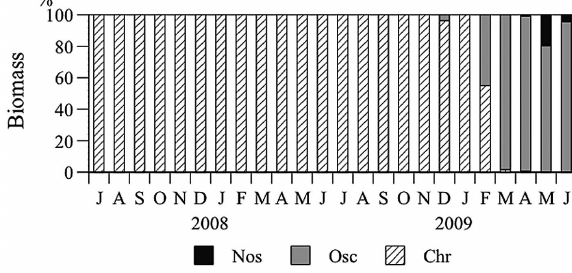
Fig . 6. – Seasonal dynamics of the biomass of Chroococcales (Chr), Oscillatoriales (Osc), and Nostocales (Nos) in Cabras Lagoon dur- ing the investigation period. Data are the mean values obtained from the three sampling stations.